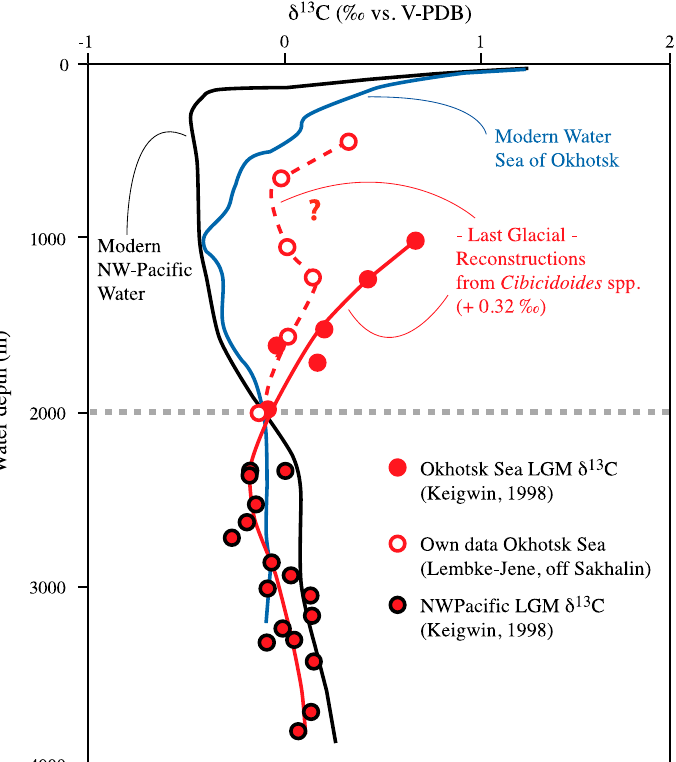
Figure 4. Last Glacial Maximum δ 13 C-based North Pacific depth transect indicative of ventilation patterns. Measurements are based on cores that were retrieved between 1992 and 2004 on a number of subsequent expeditions to the Okhotsk Sea under the frameworks of joint bilateral projects KOMEX, KOMEX II, and KOMEX-SONNE, here shown in comparison to existing data from the Okhotsk Sea and Northwest Pacific [62]. Red open circles denote own unpublished results from water depths between 500 and 2000 m. Filled red circles indicate measurements carried out by Keigwin [62]. Blue solid line shows modern δ 13 C of dissolved inorganic carbon in the Okhotsk Sea, and black lines in the open North Pacific. The results indicate that a previously inferred hydrographic boundary along 2000 m water depth, separating the glacial deep from the mid-depth subarctic North Pacific Ocean probably did not exist in terms of large ventilation differences.